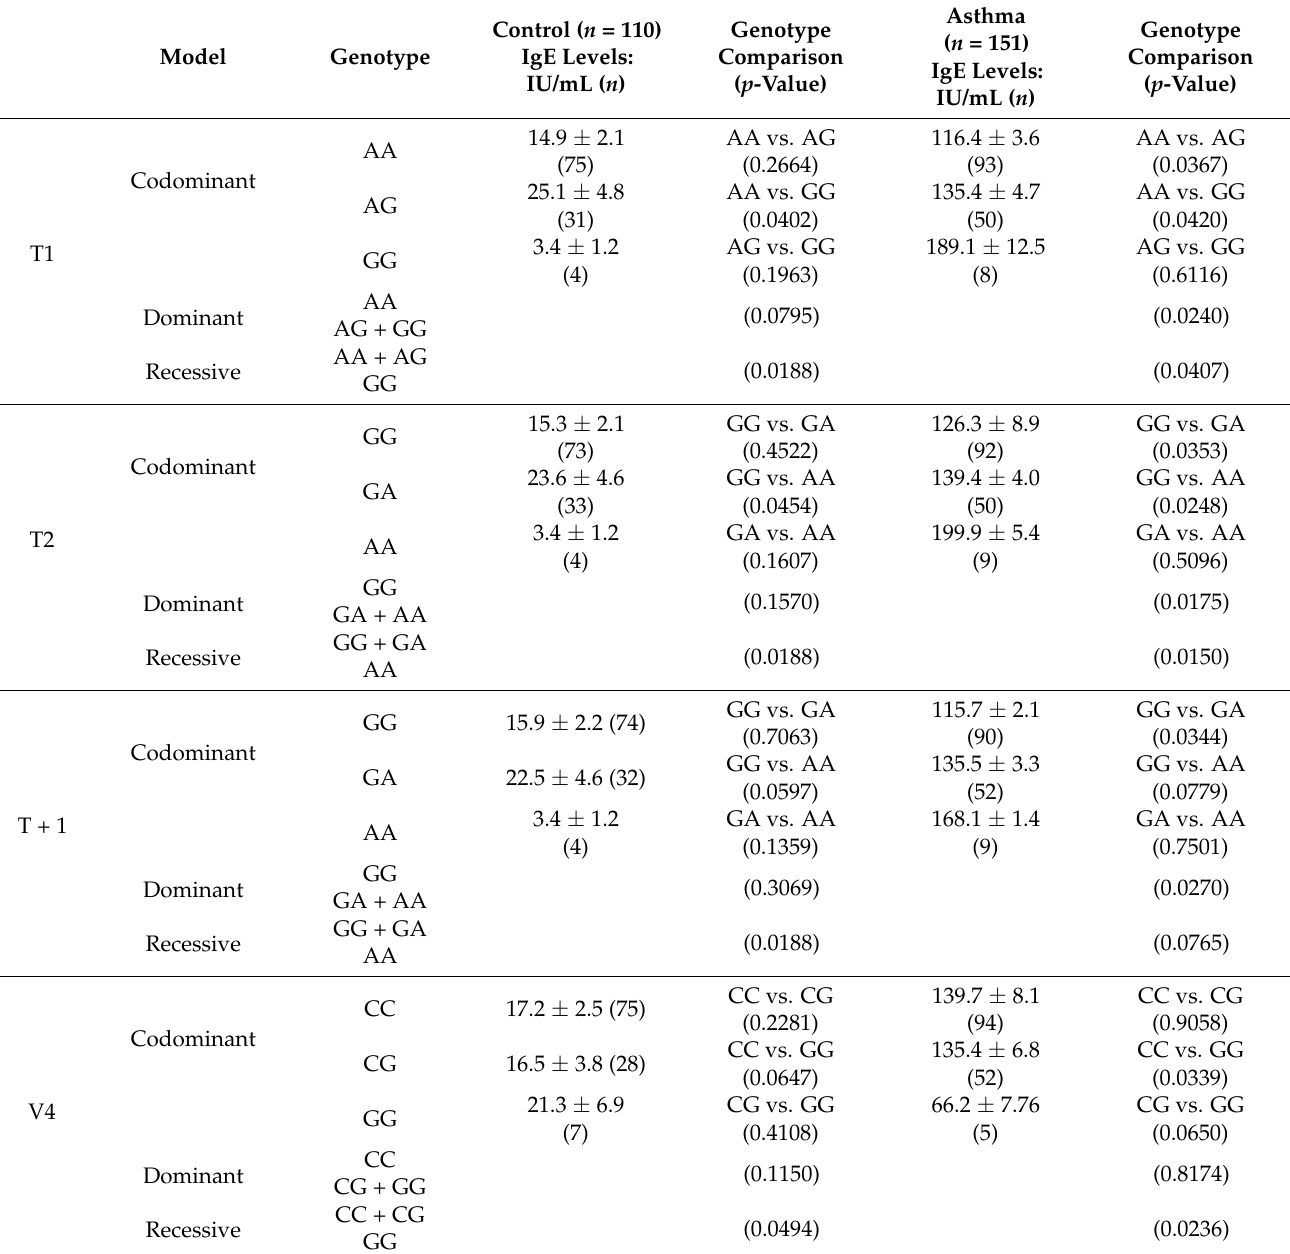
Table 5. Comparison between IgE levels of asthma patients and control group according to ADAM33 SNPs in adults.